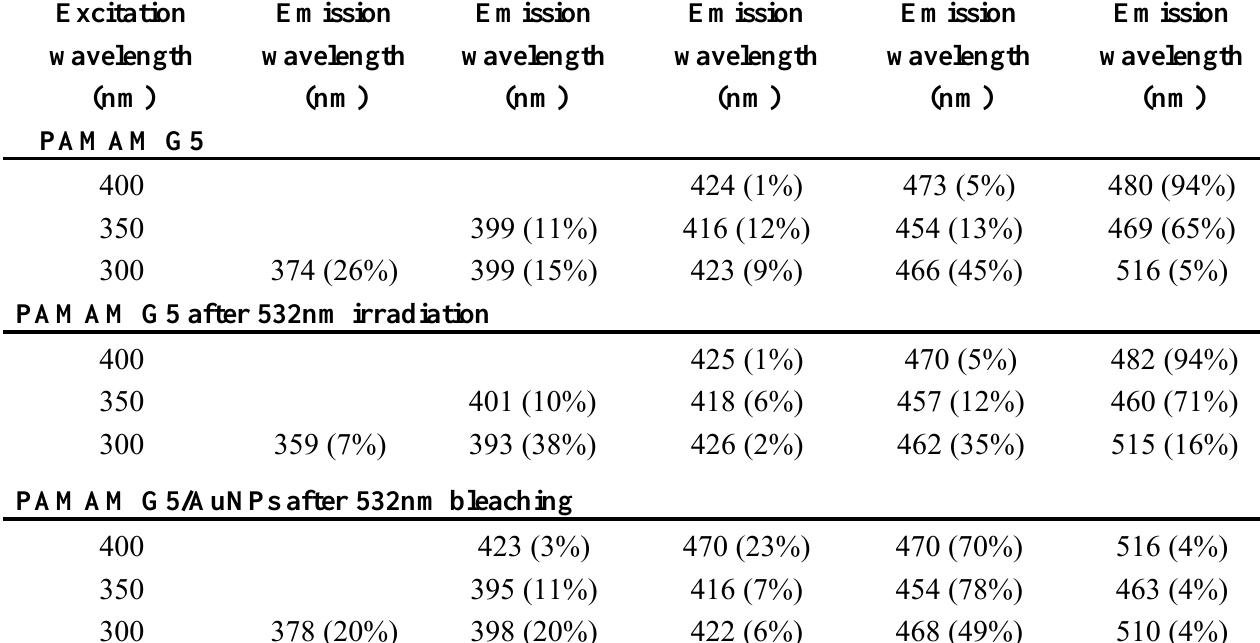
Table 1. Deconvolution of the fluorescence spectra of Figure